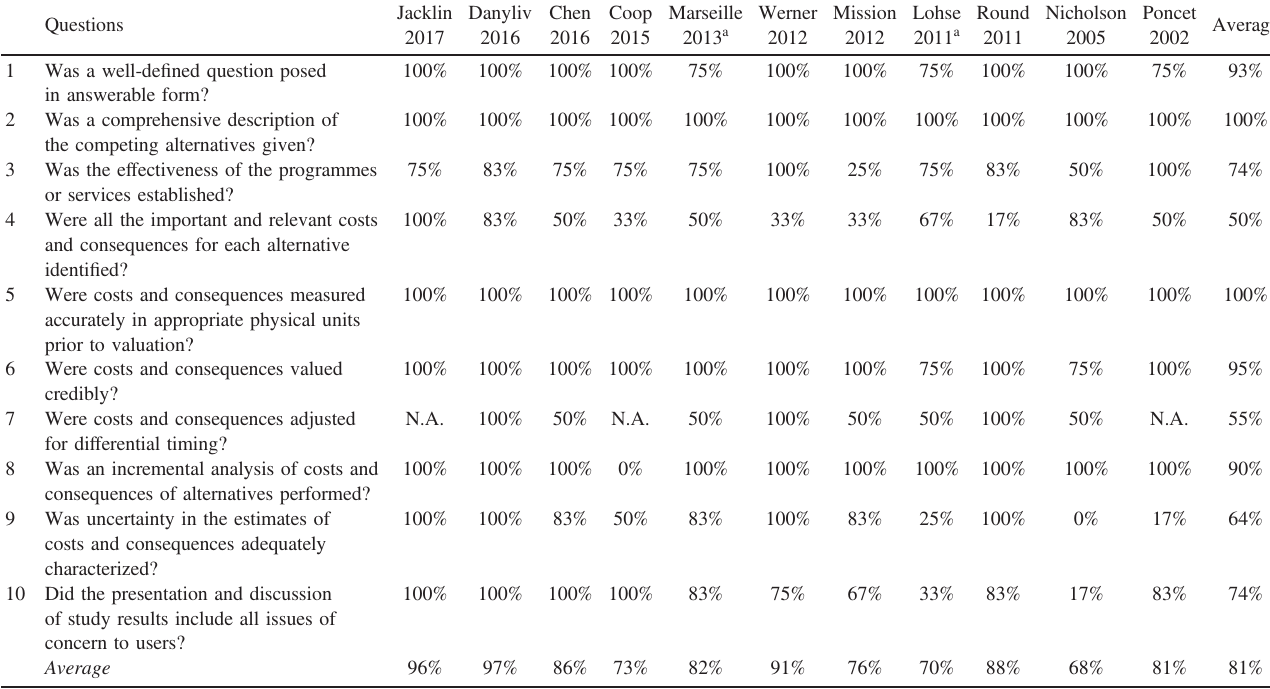
Table 4. Critical assessment (Methods for the Economic Evaluation of Health Care Programmes: Assessing Economic Evaluations Checklist)